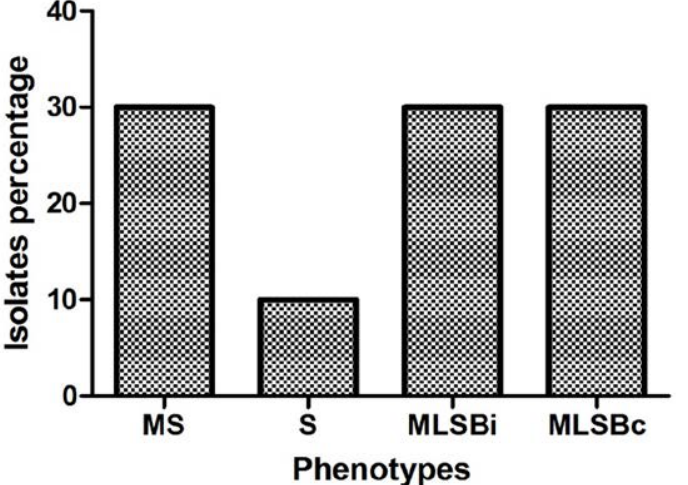
Fig. 1. Resistant phenotypes among S. aureus strains. Erythromycin-sensitive, Clindamycin-sensitive (S); Erythromycin- resistant, Clindamycin-resistant (constitutive MLSB); Erythromycin-resistant, Clindamycin-sensitive, D-test positive (inducible MLSB); Erythromycin-resistant, Clindamycin-sensitive, D-test negative